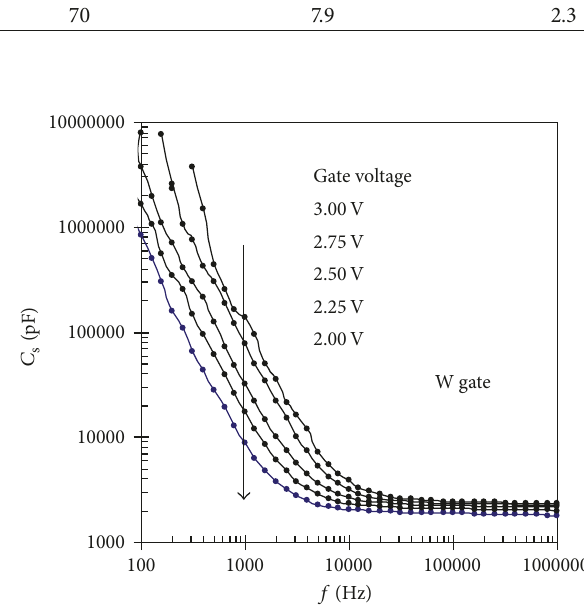
Figure 3: 𝐶 - f characteristics in the case of an Au gate. s